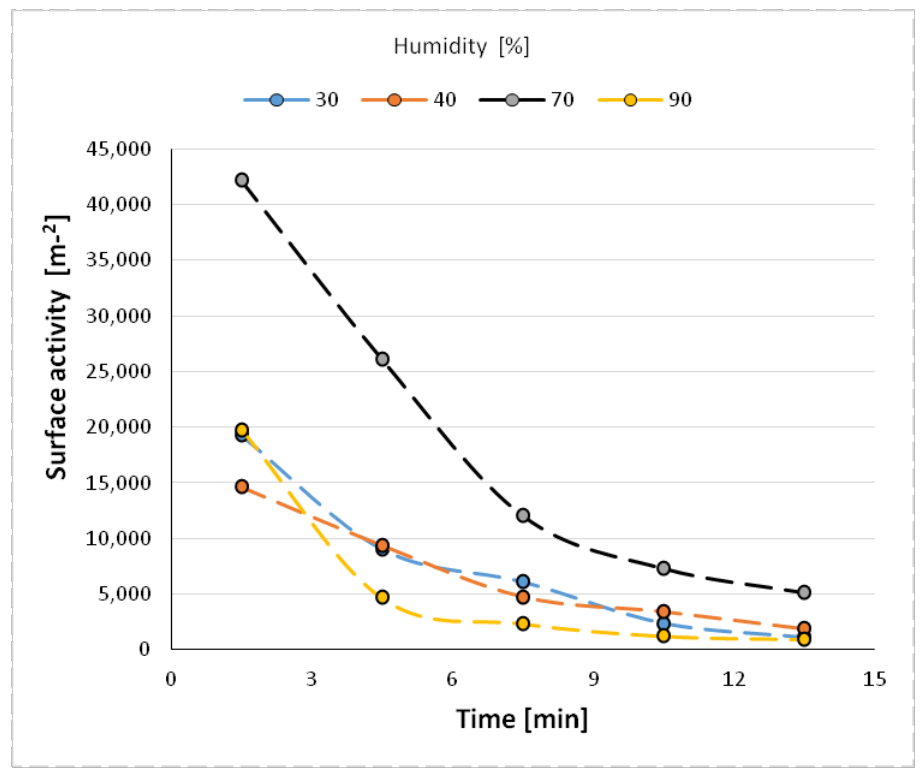
Figure 13. Aerosol atomization activity as a function of humidity and time.